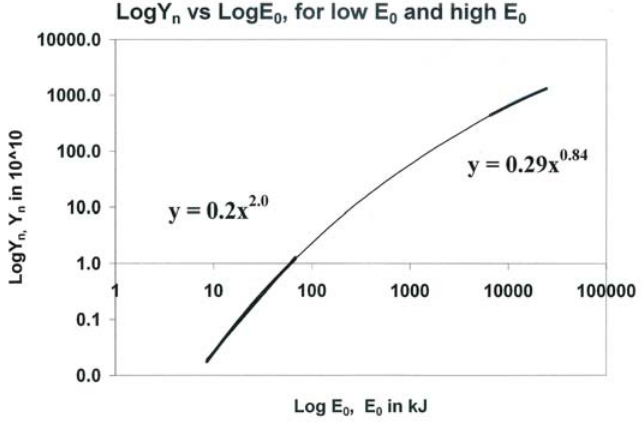
Figure 8 . Y plotted as a function of E n Y ~ E 02.0 at tens of kJ to Y n